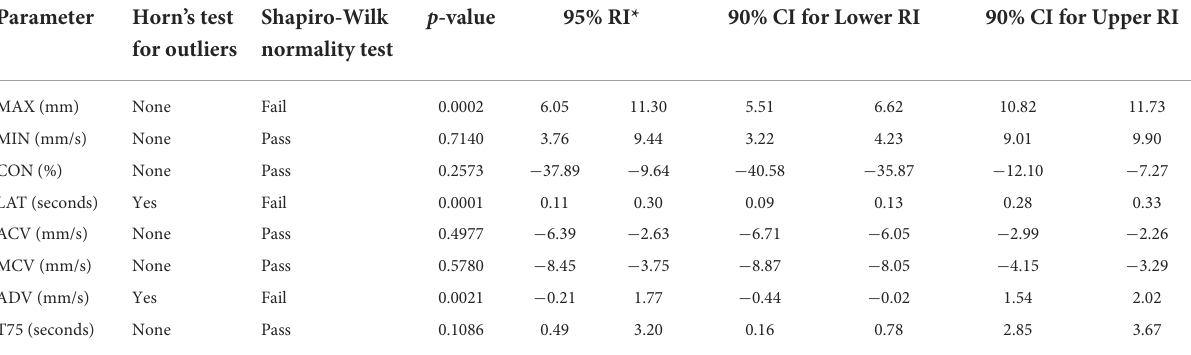
TABLE 2 Statistics, reference intervals and confidence intervals for pupillometry